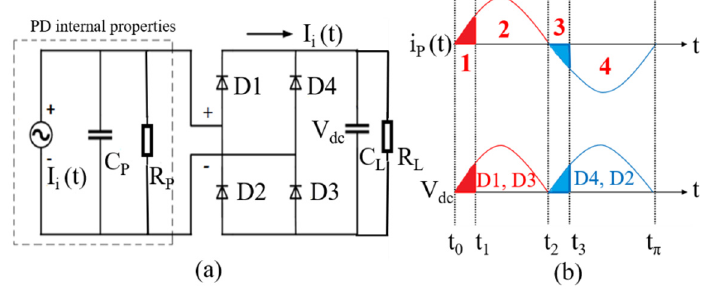
Figure 3. AC-DC rectification using FBR circuit ( a ) PD and FBR circuit, ( b ) Output waveforms.